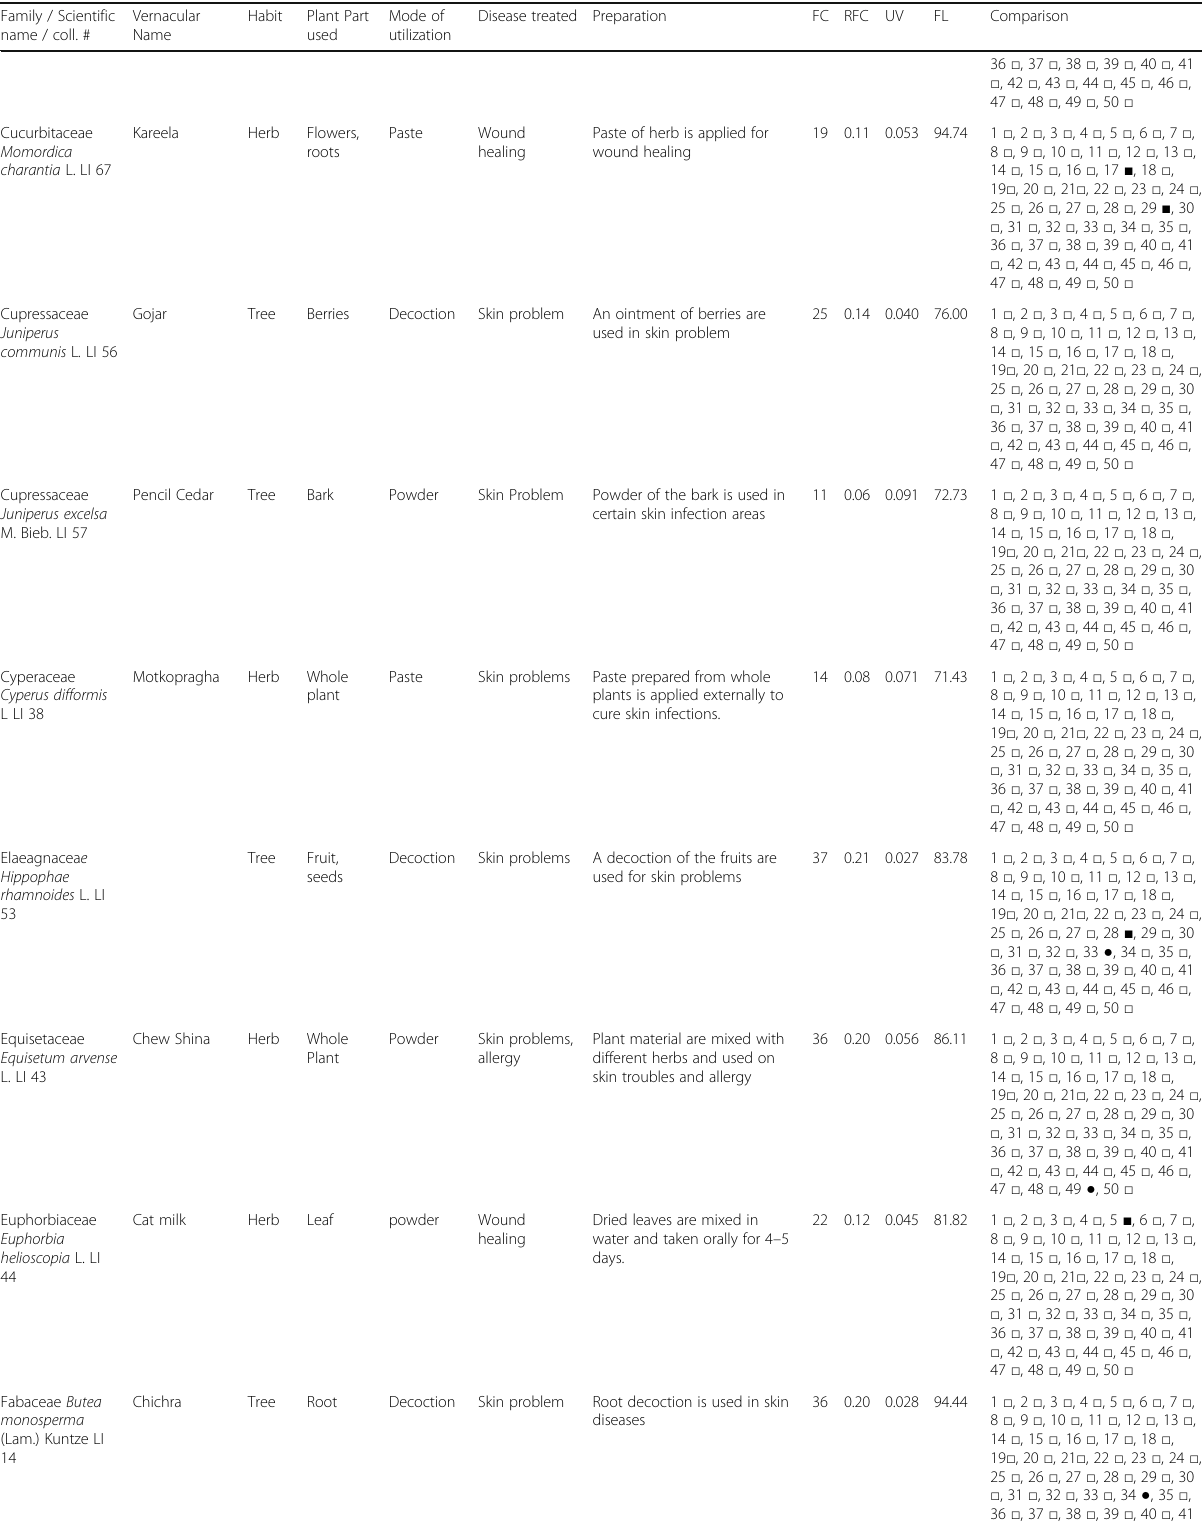
Table 2 Medicinal plants used for skin diseases in Northern Pakistan (Continued) Family / Scientific name / coll.